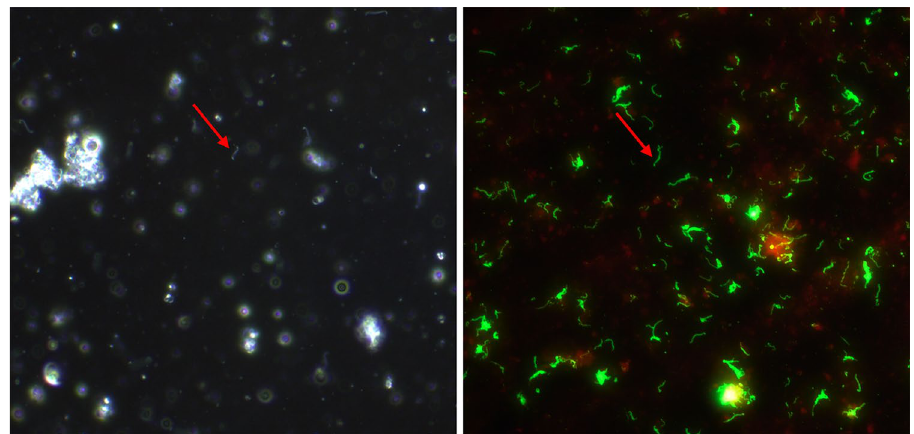
Figure 2. Representative images of a rodent kidney sample that was positive for leptospires by ( A ) dark-field microscopy and ( B ) fluorescent antibody test (FAT). Red arrows indicate leptospires. Original magnification